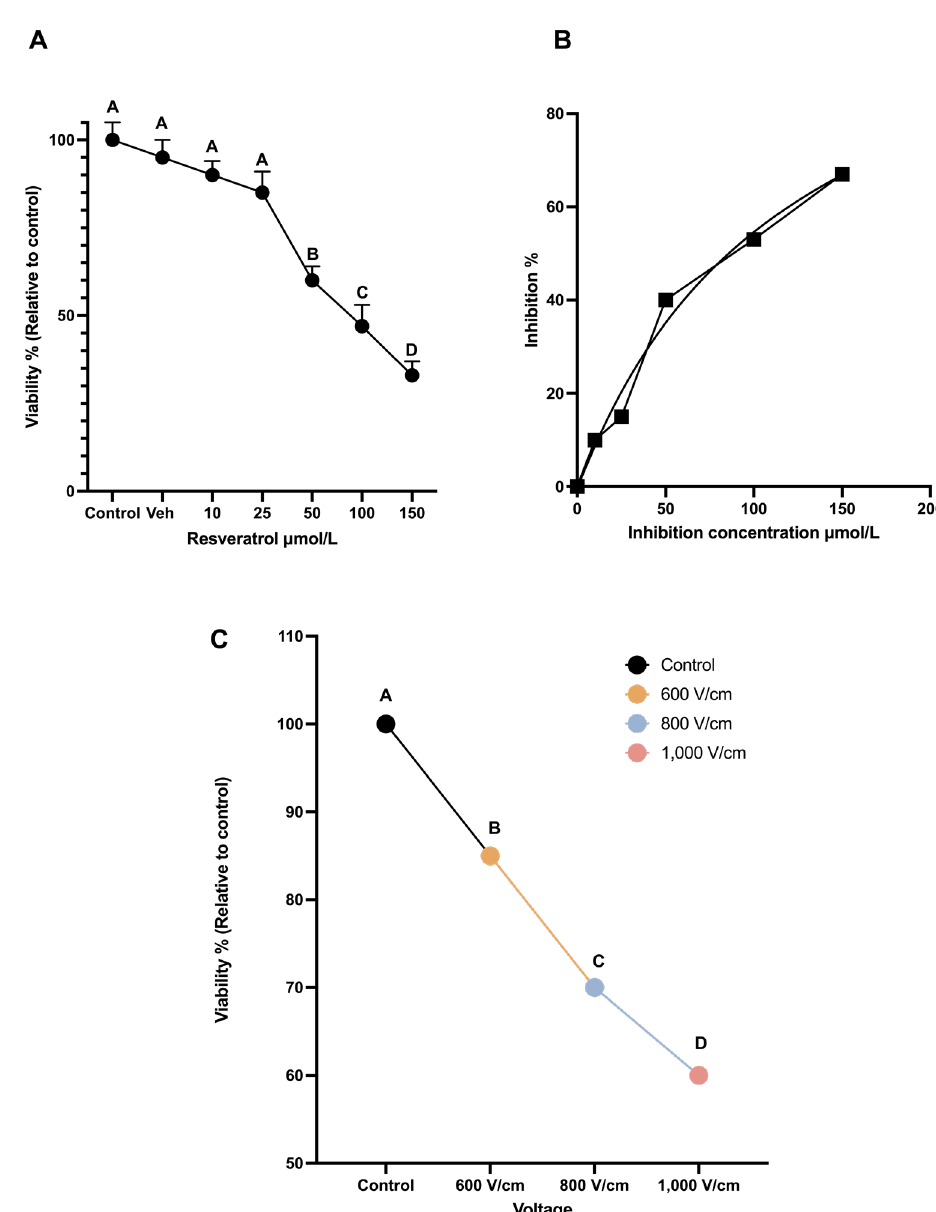
Figure 3. Cell viability studies on MDA-MD-231. (A) The dose-dependent cell viability of MDA-MB-231 cells with various concentrations of RESV; (B) inhibition concentration curve indicating cell death due to RESV only at various concentrations; (C) the percentage of cell viability with respect to control when various voltages are administered. The same letter A for samples of control, and up to 25 μmol/L, indicates that there are no statistically significant changes. The different letters, B, C, and D indicate that the viabilities of these samples are significantly different. Veh: